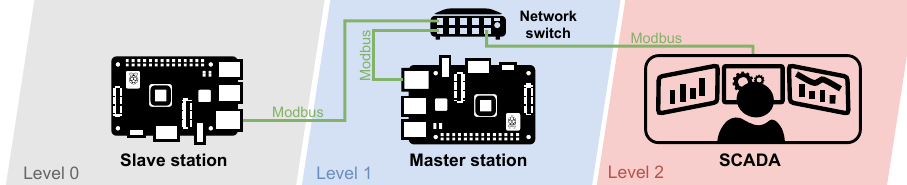
Figure 10. Diagram of brewery testbed.